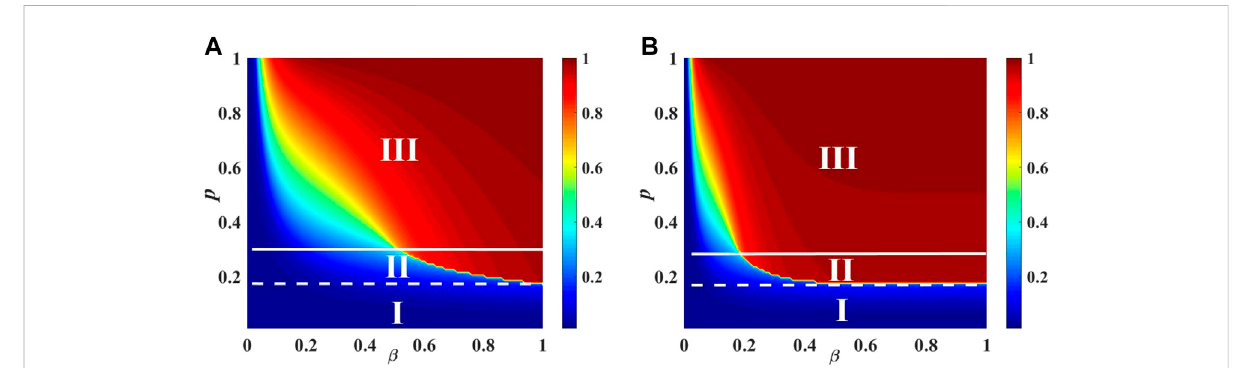
FIGURE 3 The fi nal adoption size of a single weighted ER network is affected by the interaction of the unit propagation probability of beta and the active student part of p. There was no global behavior outbreak, discontinuous phase transition, or continuous phase transition in regions I, II, or III as described in subparagraphs (A) and (B) ( α ω = 2 and 3, respectively). Other parameters are ρ 0 = 0.01, T p = 1, and T q =